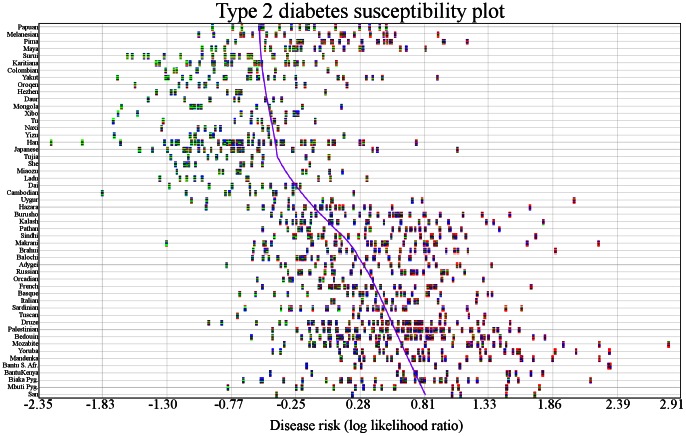
Variability in genetic risk for type 2 diabetes.Individuals are represented by vertical multicolored rectangles. Individual bars in each rectangle represent one of the 16 SNPs associated with type 2 diabetes. Bar colors indicate the following: red: homozygosity for a risk allele; blue∶heterozygosity; green∶homozygosity for a protective allele; white: missing genotype. The order of the SNPs is preserved across individuals. The x-axis shows genetic risk and the y-axis shows each population. The purple line is a locally weighted linear regression curve displaying the general direction of disease susceptibility as populations migrated from West to East. Genetic risk is lower in East Asians.